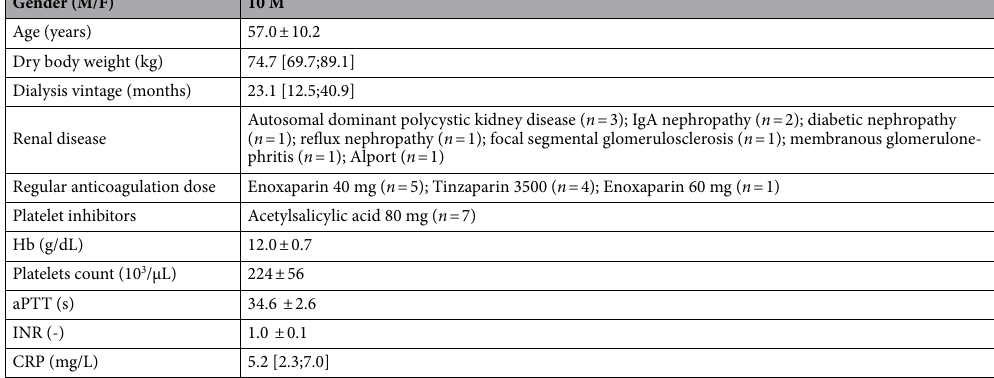
Table 1. Demographic and clinical data of the patient population at baseline. Hb: hemoglobin; aPTT: activated partial thromboplastin time; INR: international normalized ratio; CRP: C-reactive